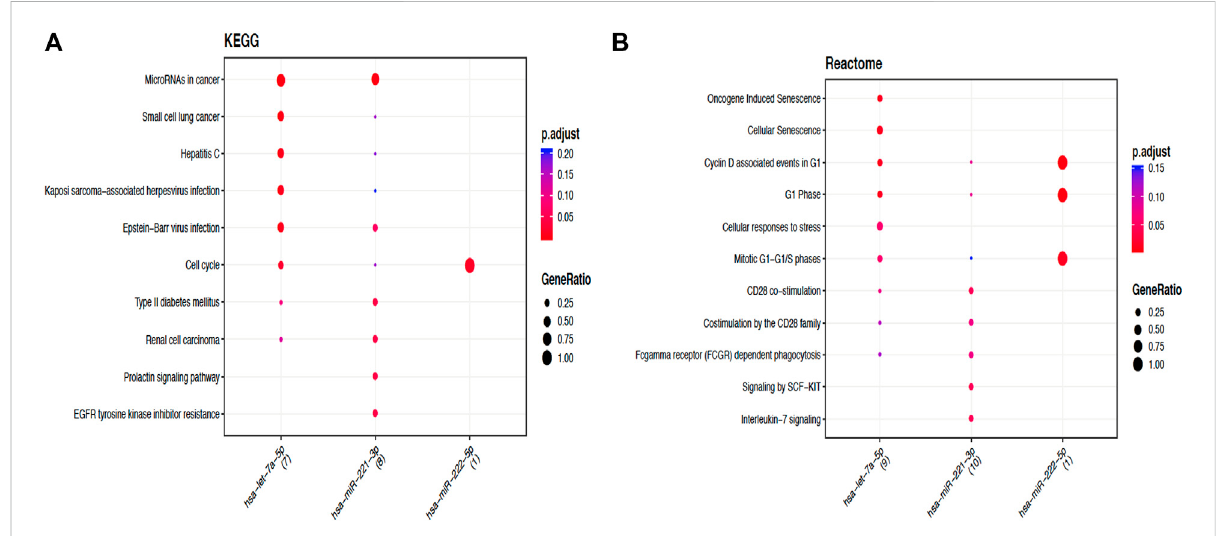
FIGURE 10 Functional enrichment analysis of target genes associated with HCC. (A) . Dotplot of the KEGG signal pathway showing the counts of genes. Functional enrichment analysis of target genes associated with HCC. (B) Reactome of the KEGG signal pathway showing the “ pathway – gene ”